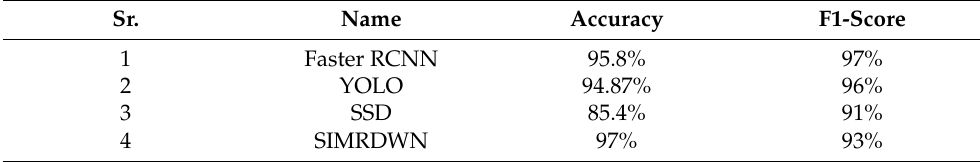
Table 6. Accuracy comparisons of different deep learning object detection models for satellite imagery. Sr.